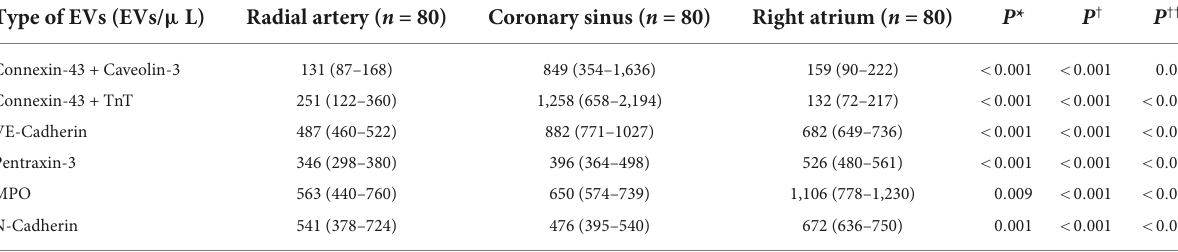
TABLE 3 Concentration in plasma of extracellular vesicles collected from the radial artery, coronary sinus, and right atrium in all patients, irrespective of heart failure phenotype or coronary artery disease severity grading. Type of EVs (EVs/ µ L) Radial artery ( n =